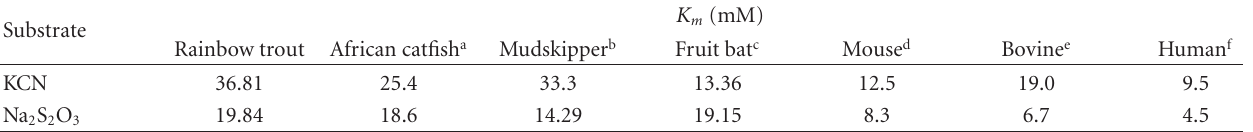
Table 2: Comparison of K m values for rainbow trout liver with other liver rhodanese preparations. Substrate